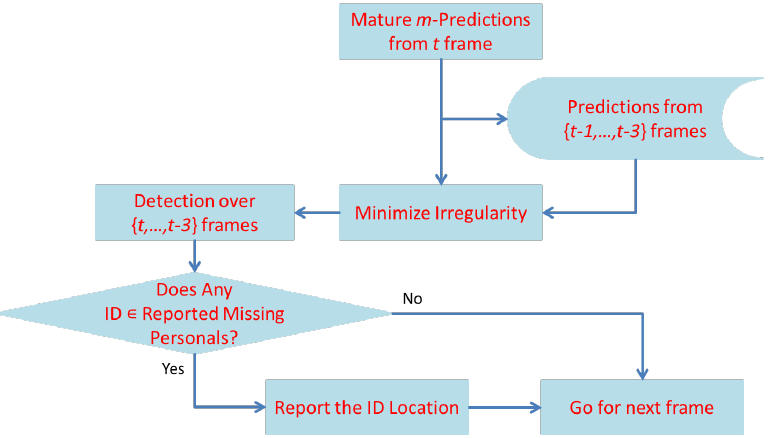
Figure 6. Tracking in spatio-temporal context.